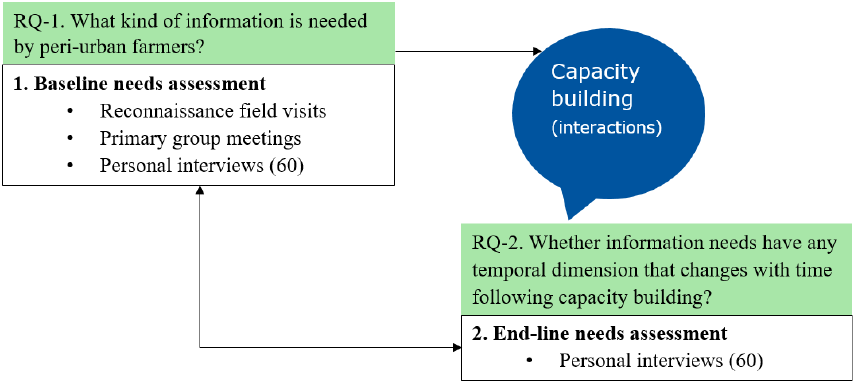
Figure 2. Primary data collection framework including the steps and participatory tools that were employed in the current study.